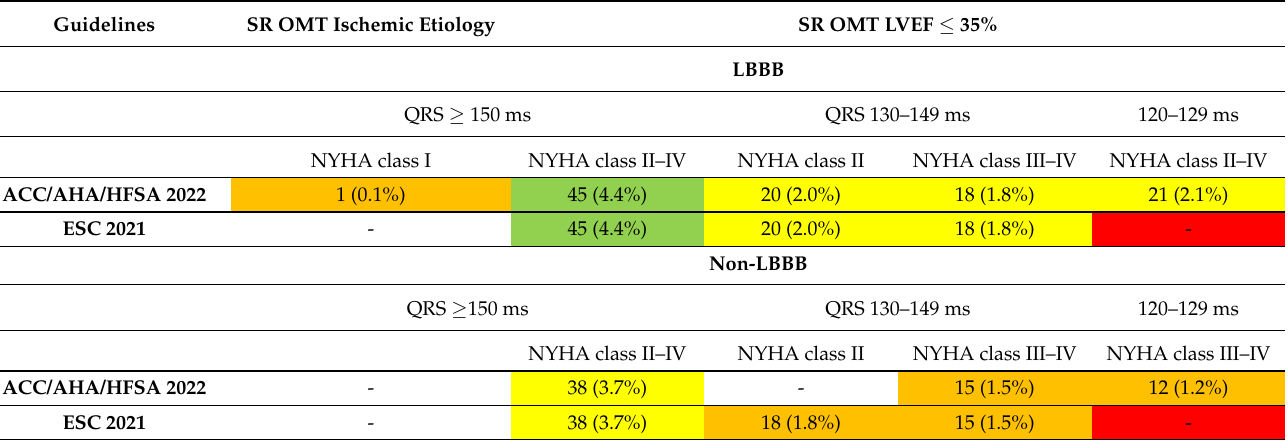
Table 3. Patients with heart failure and sinus rhythm eligible for CRT based on the recent ACC/AHA/HFSA (2022) and ESC (2021)